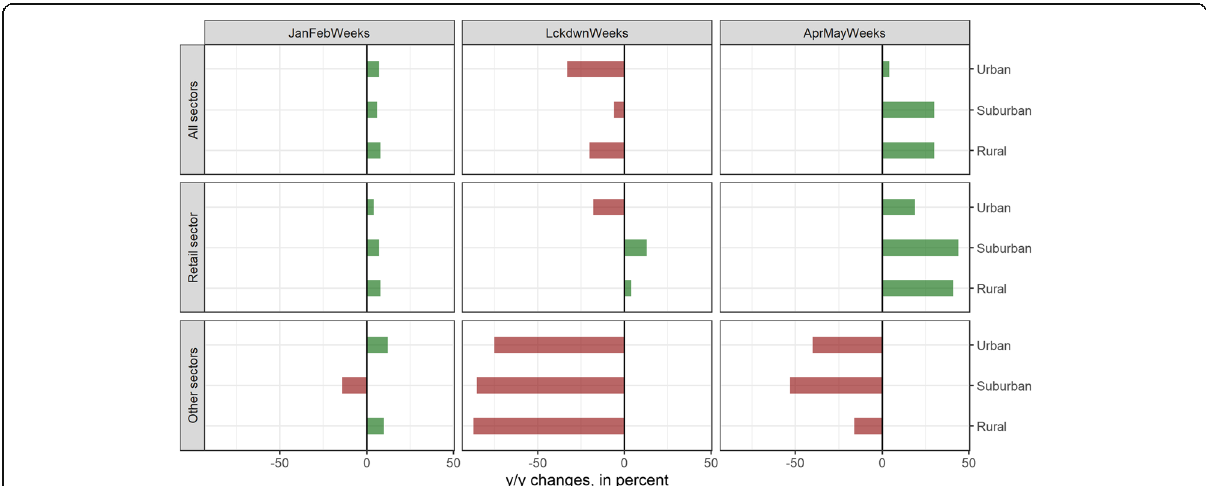
Fig. 7 Excess card payments (percentages) for all sectors (upper panel), the retail sector (middle panel), and all other sectors (lower panel), differentiated by urban, suburban, and rural areas in Switzerland (sub-panels) in the pre-lockdown (right), lockdown (middle), and post-lockdown (left) periods. Source: Own calculations, Worldline/SPS